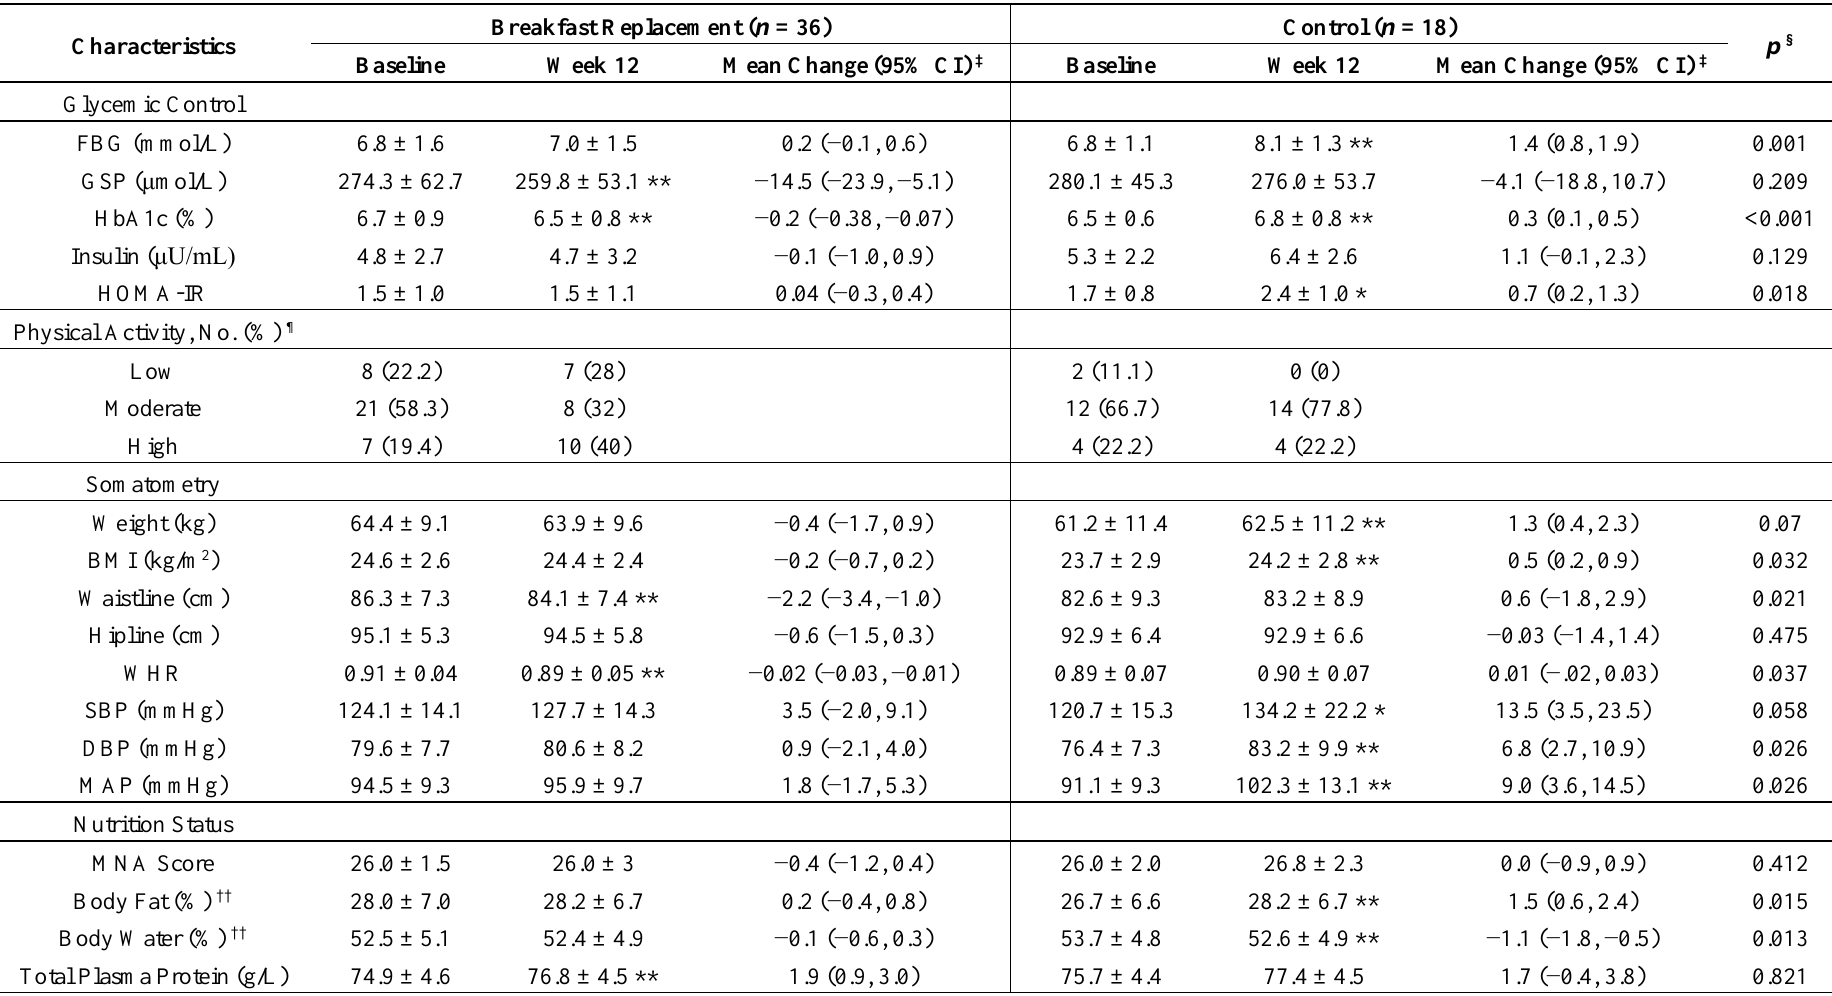
Table 3. Biochemistry and somatometry of control and treatment groups at baseline and week 12 † (Mean ± SD).